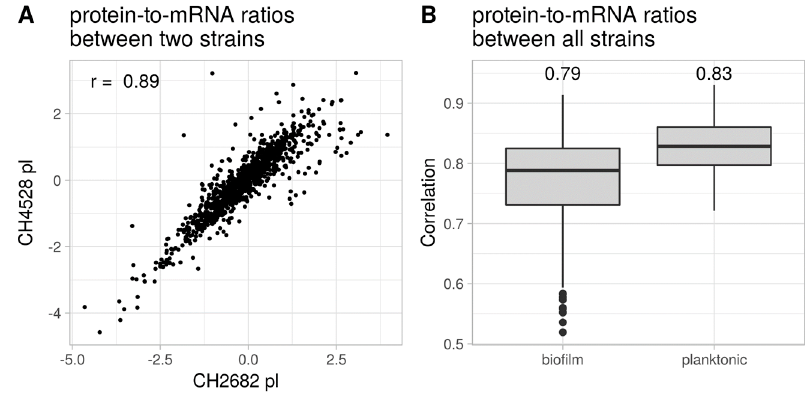
Figure 6. Protein-to-mRNA ratios across clinical P. aeruginosa isolates. ( A ) Exemplary plot of protein-to-mRNA correlation between two strains under planktonic condition. r = Pearson correlation ( B ) Median and interquartile range of the pair-wise correlation coefficients of all protein-to-mRNA ratios of the 27 strains under biofilm and planktonic conditions. Values on top of the boxplots represent the corresponding median.